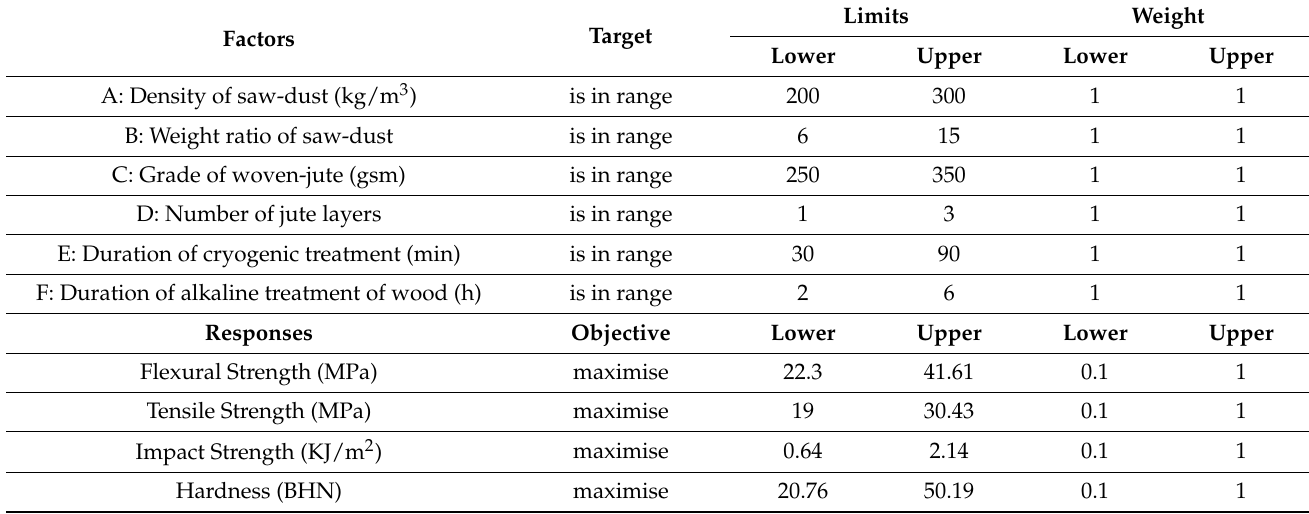
Table 8. The criteria for optimisation with an objective to maximise the mechanical properties. A weighting of 1 indicates more emphasis to the objective, while 0.1 indicates less emphasis.